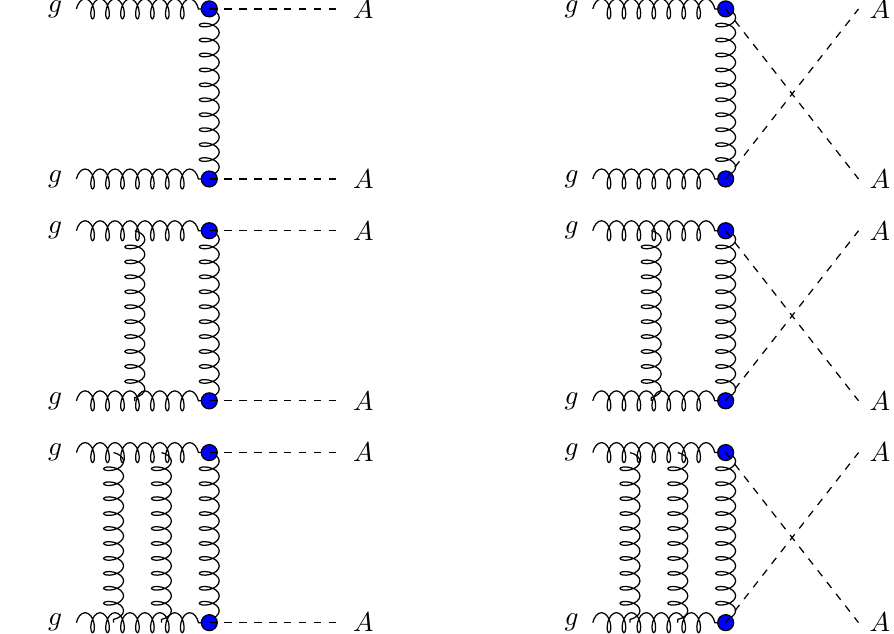
Figure 2 . Type-IIa: sample diagrams of amplitudes up to two-loop involving two Agg e(cid:11)ective vertex.